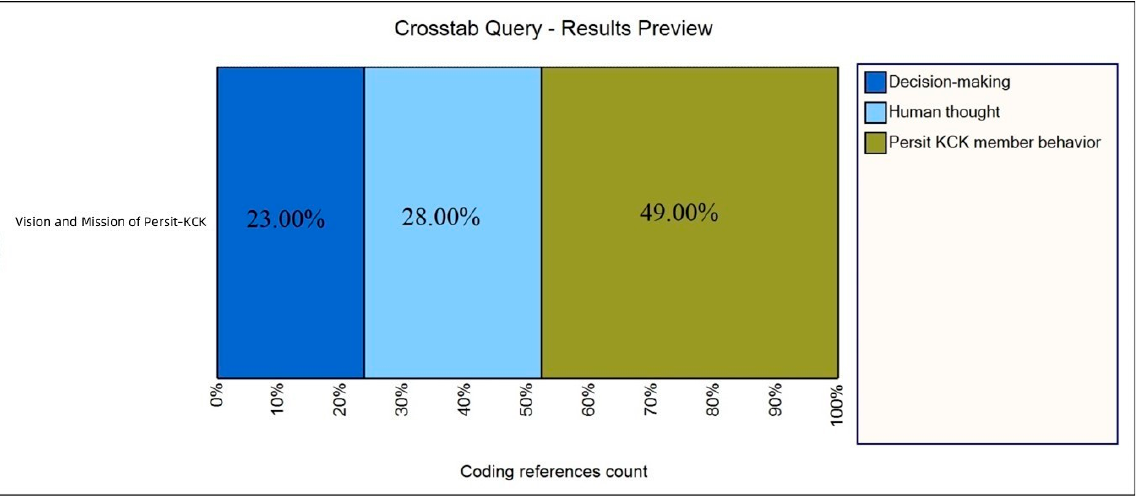
Figure 5. Analysis of the influence of Persit-KCK’s vision and mission on three indicators of social behavior. Source: processed from Nvivo 12 Pro , 2022.